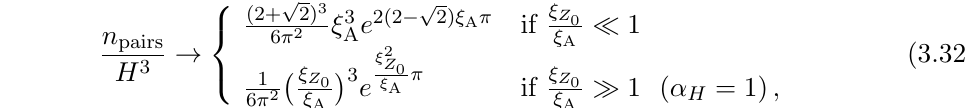
Figure 4 . The number density of the created pairs, n pairs =H 3 , as a function of (cid:24) A and (cid:24) Z The particle production increases exponentially with ( j (cid:20) j(cid:0)j (cid:22) j ) and has the following asymp- totic